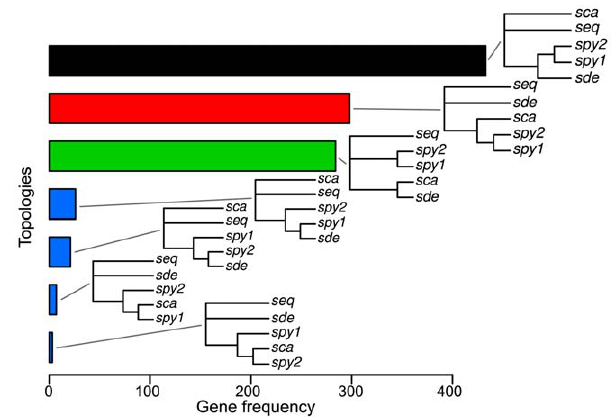
Figure 2. The seven topologies and the number of genes mapped to them, found by the Bayesian gene tree concor- dance analysis.